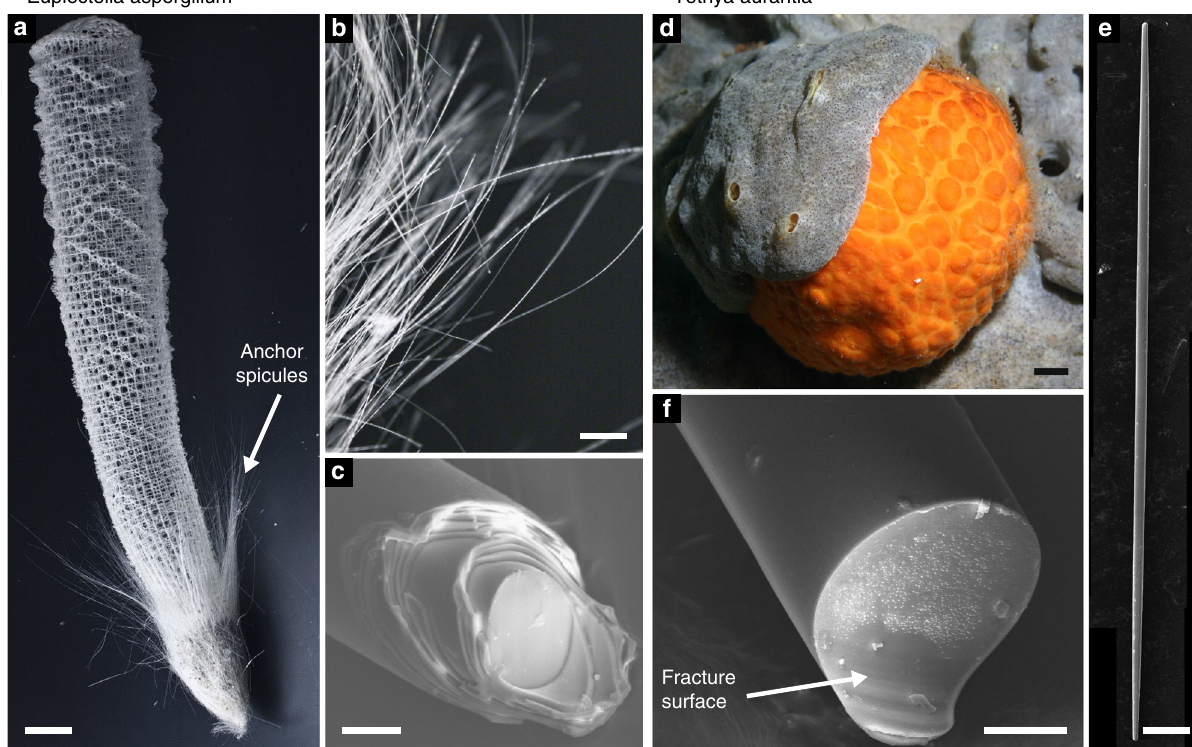
Fig. 2 The skeletons and spicules of Ea . and Ta . sponges. a The skeleton of the Ea . sponge (modi fi ed from 16 copyright, the National Academy of Sciences). b The anchor spicules that fasten the sponge to the sea fl oor (modi fi ed from 16 copyright, the National Academy of Sciences). c The broken end of an Ea . anchor spicule that was fractured in three-point bending showing its layered architecture (modi fi ed from 32 copyright 2017, Elsevier). d A Ta . sponge (image courtesy of Steve Lonhart/NOAA MBNMS). e A toothpick-like spicule found within the Ta . sponge (reproduced from 26 under the Creative Commons 4.0 BY license). f The exposed surface of a Ta . spicule that was fractured in the same way as the Ea . spicule shown in c showing that it does not contain a layered architecture (modi fi ed from 32 copyright 2017, Elsevier). Scale bars: a ≈ 2 cm; b 2 mm; c 25 μ m; d ≈ 1 cm; e 125 μ m; f 10 μ